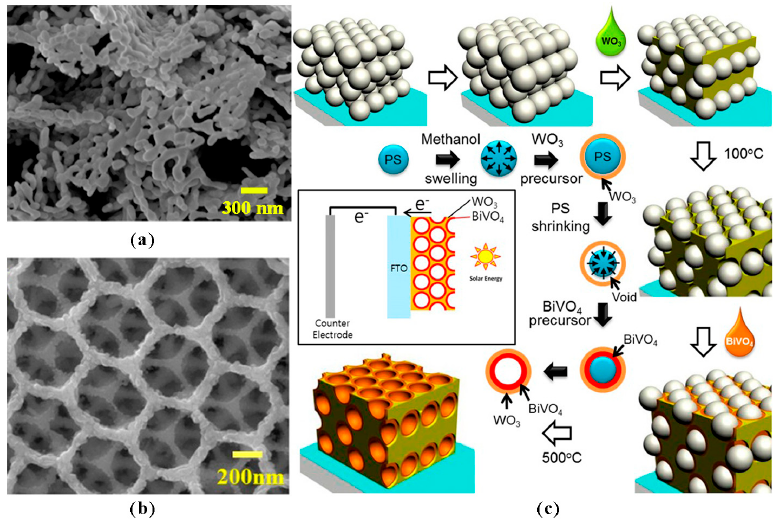
Figure 2. Morphology enhancement techniques for BiVO 4 synthesis. ( a ) Field emission scanning electron microscopy (FE-SEM) image of porous BiVO 4 on FTO that the authors synthesized using the electrodeposition route suggested by Kim & Choi [43]. ( b ) SEM image and ( c ) schematic diagram of the synthesis of double-deck inverse opal WO 3 /BiVO 4 synthesized by Ma et al., adapted with permission from [65], Copyright American Chemical Society,